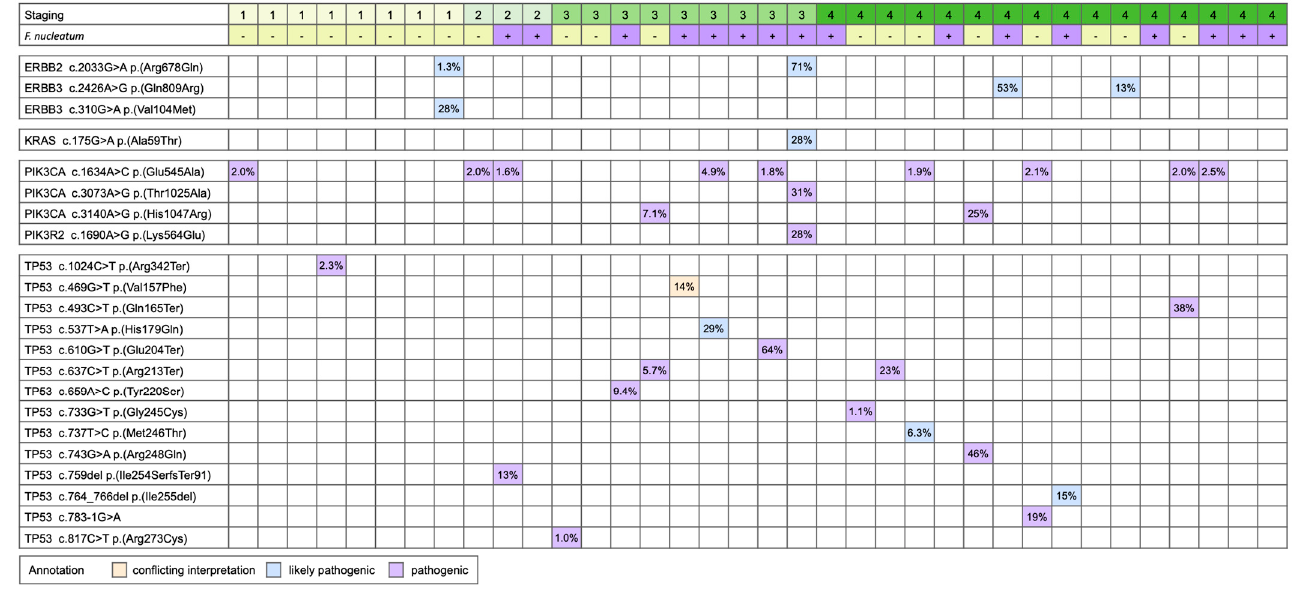
Figure 2. The pathological and likely pathogenic variants identified in the study